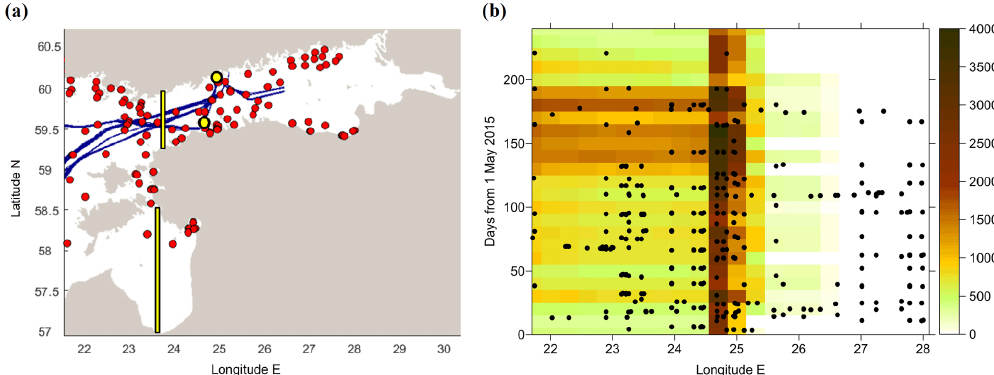
Figure 2. Distribution of observations. (a) Map of FerryBox observation points along ship tracks (blue) and shipborne monitoring ob- servations (red) over the study period. Shown are also the locations for time–latitude graphs and time series (black contours with yellow background). (b) Observation frequency over longitude and time. FerryBox data are shown by colour image; each image cell presents the number of initial observations over intervals of 10d and 18 arcmin of longitude (ca. 16.7km). Shipborne observations are shown by black